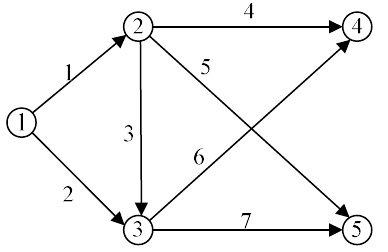
Figure 2. Example road network diagram. Table 1. Road network attribute table.